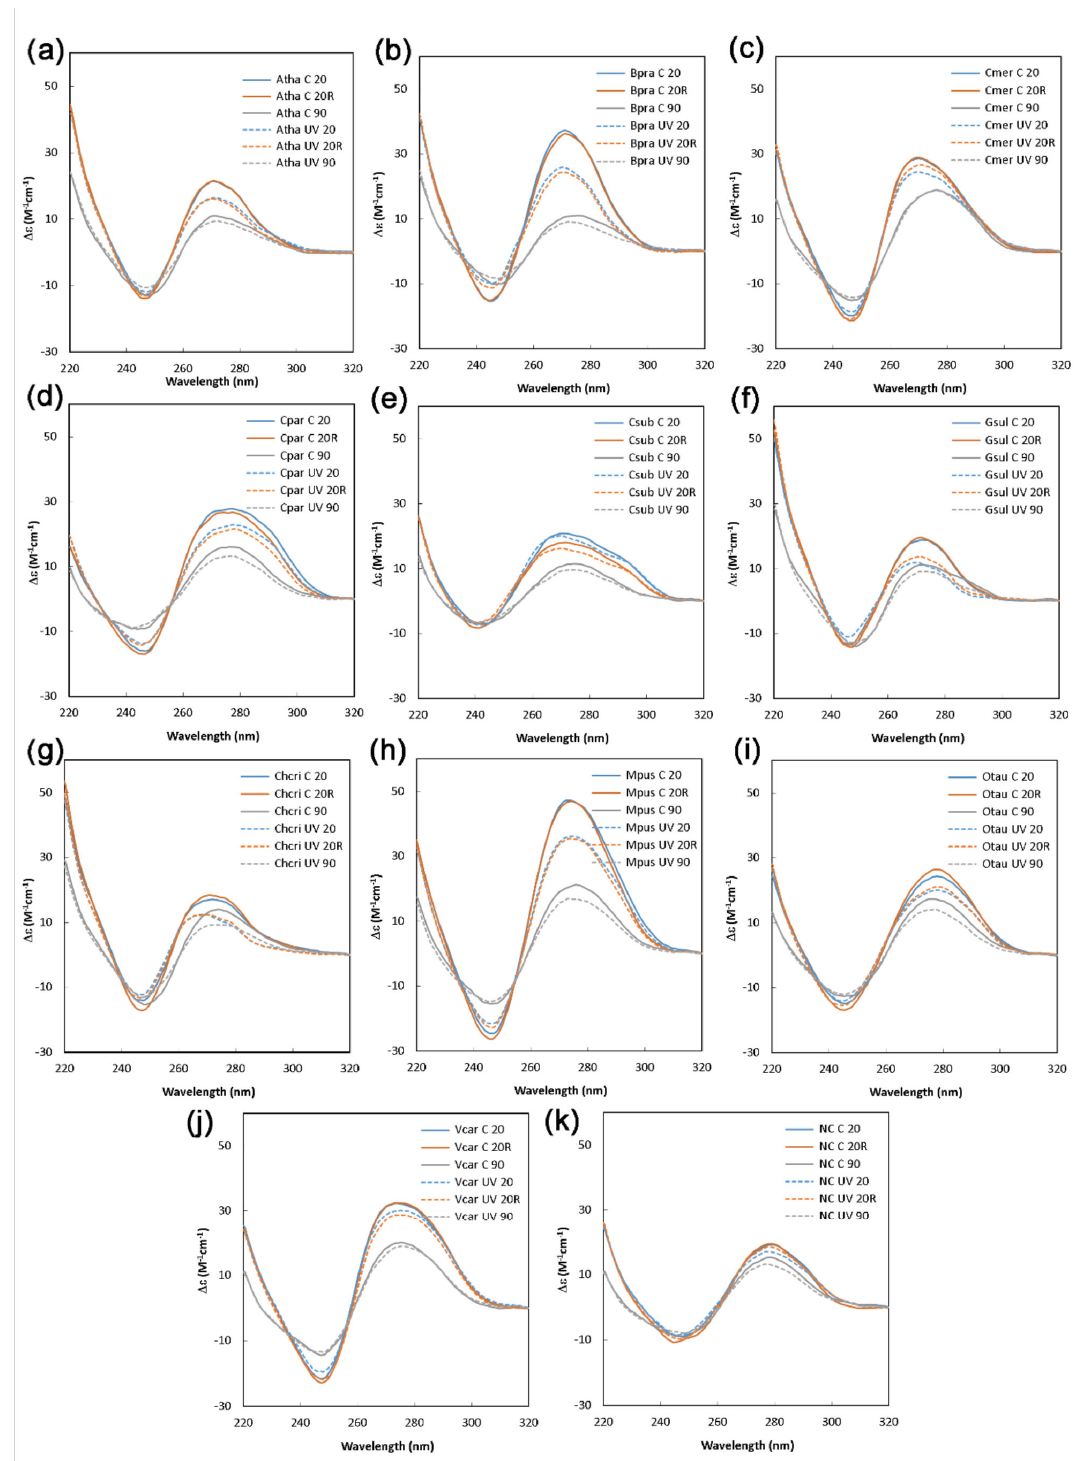
Figure 3 . CD spectra of putative G4s in the RPB1 gene in selected plant species. ( a ) Atha— Arabidopsis thaliana ; ( b ) Bpra— Bathycoccus prasinos ; ( c ) Cmer— Cyanidioschyzon merolae ; ( d ) Cpar— Cyanophora paradoxa ; ( e ) Csub— Coccomyxa subellipsoidea ; ( f ) Gsul— Galdieria sulphuraria ; ( g ) Chcri— Chondrus crispus ; ( h ) Mpus— Micromonas pusilla ; ( i ) Otau— Ostreococcus tauri ; ( j ) Vcar— Volvox carteri , ( k ) including negative control (NC). CD spectra were measured at 20 °C (20; blue line), after denaturation (90; grey line) and renaturation (20R; red line) without (C; solid line) or with previous UV irradiations (UV; dashed line). The total exposure was for one hour at 4.1 W/m 2 of UV ‐ A and 4.1 W/m 2 of UV ‐ B.